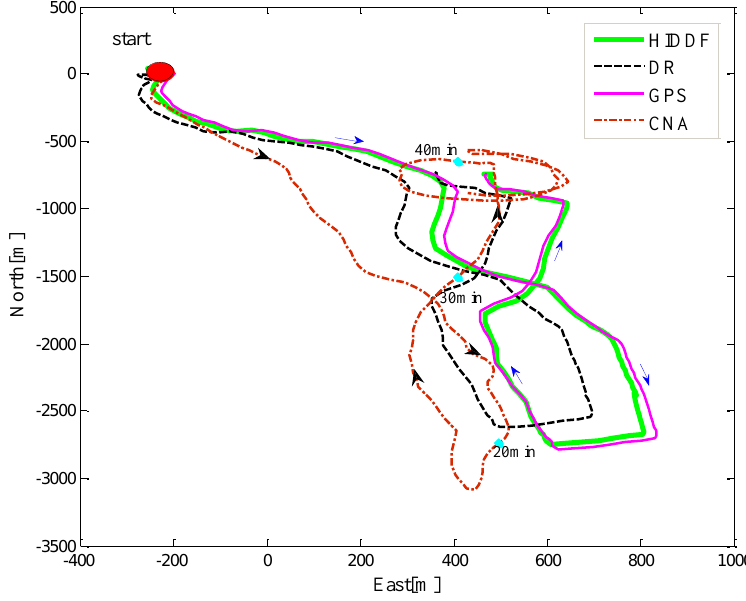
Figure 4. Paths taken by the AUV and CNA during Experiment 2. The red dash line represents the CNA movement trace and the black and blue arrows represent the direction of the CNA and AUV movement